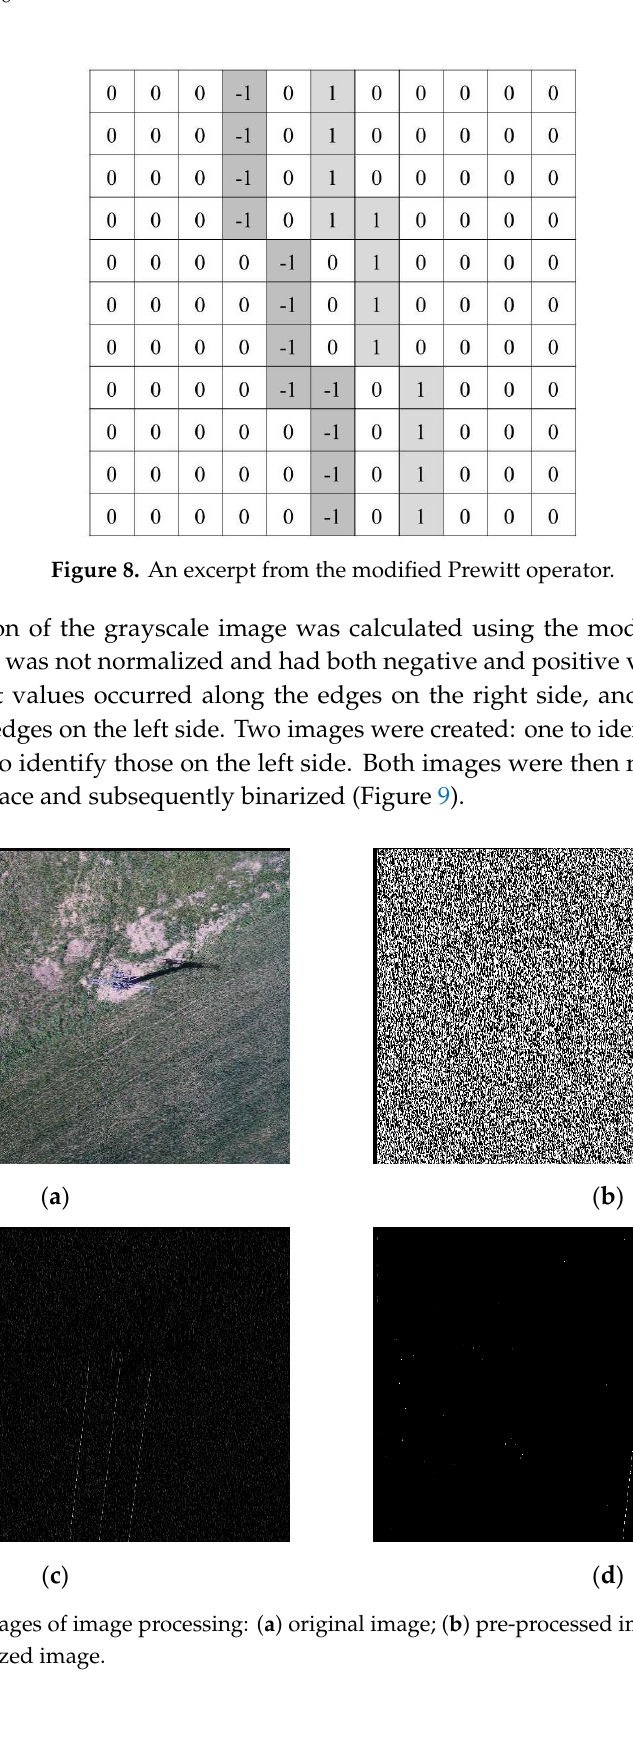
( b ) Figure 7. The same part of an example image showing power lines: ( a ) the band corresponding to the original blue band, obtained by the decorrelation stretching of the raw image; ( b ) weighted arithmetic mean of all bands (0.2989 × R + 0.5870 × G + 0.1140 × B). The edge detection operator needed to be set to enhance long, linear edges, and presumably only ones that aligned with the approximated direction of the power line. The modified Prewitt operator